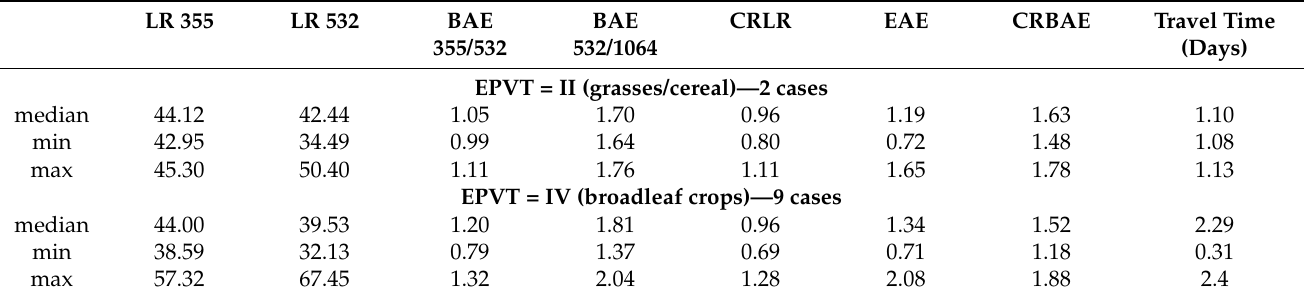
Table 5. Intensive parameters for EPVT II and